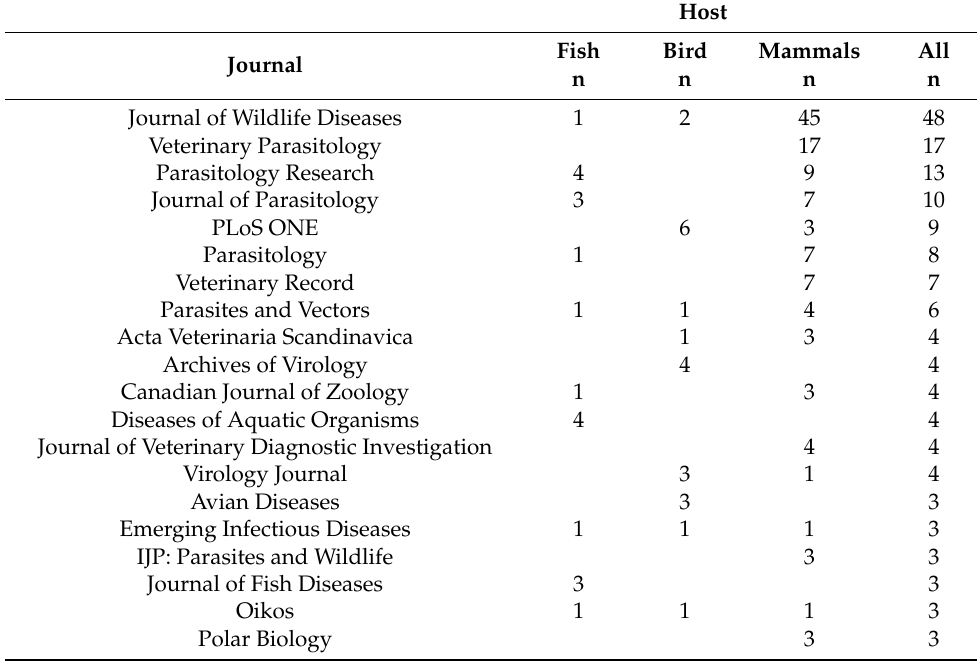
Table 2. Top English language journals, which published at least three articles on the selected wild- life infections/diseases in the circumpolar Arctic. The number of published articles is reported by the host type.